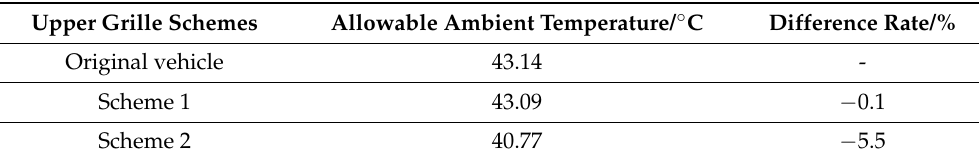
Table 5. The difference rate of the allowable ambient temperature under different schemes compared with the original vehicle.